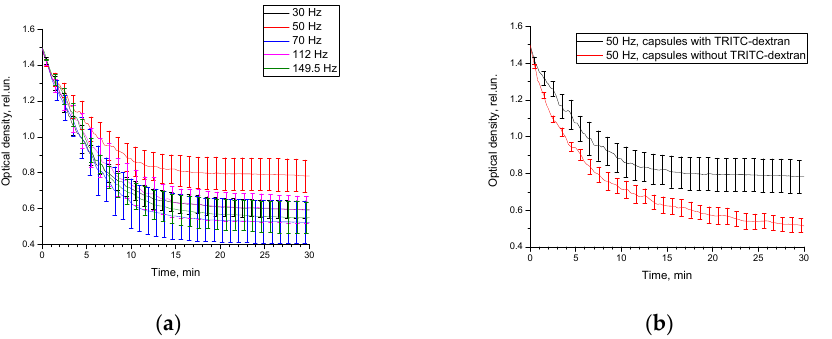
Figure 7. Optical density curves for suspension of capsules loaded with TRITC-dextran under exposure of 100 mT alternating magnetic field with frequencies 30, 50, 70, 120, 150 Hz ( a ), optical density curves for suspension of capsules loaded with TRITC-dextran and for control sample under exposure of 100 mT, 50 Hz LFMF ( b ).